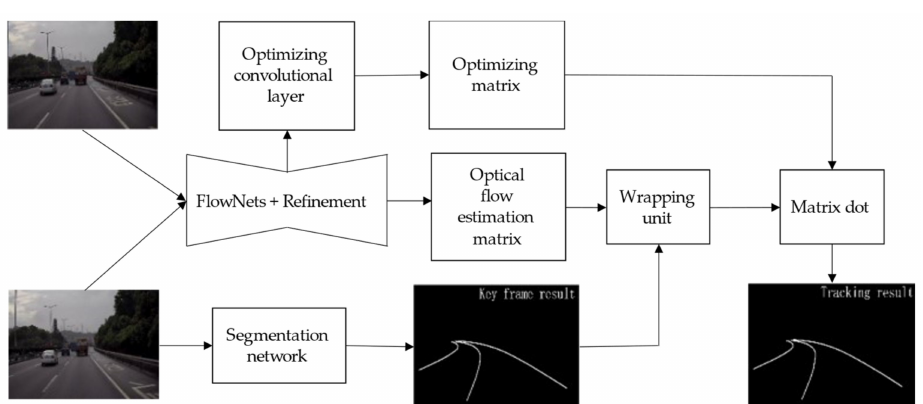
Figure 7. Location of optimizing convolutional